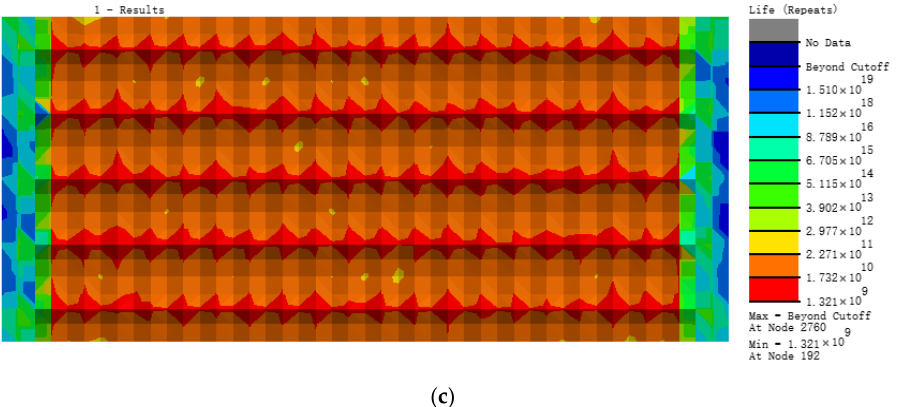
Figure 8. Nephograms of fatigue life of three models: ( a ) irregular surface, ( b ) hexagonal surface, and ( c ) quadrilateral surface models.